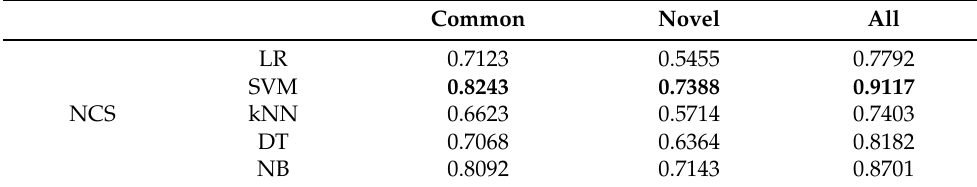
Table 2. Four-class Problem Classification Accuracy.